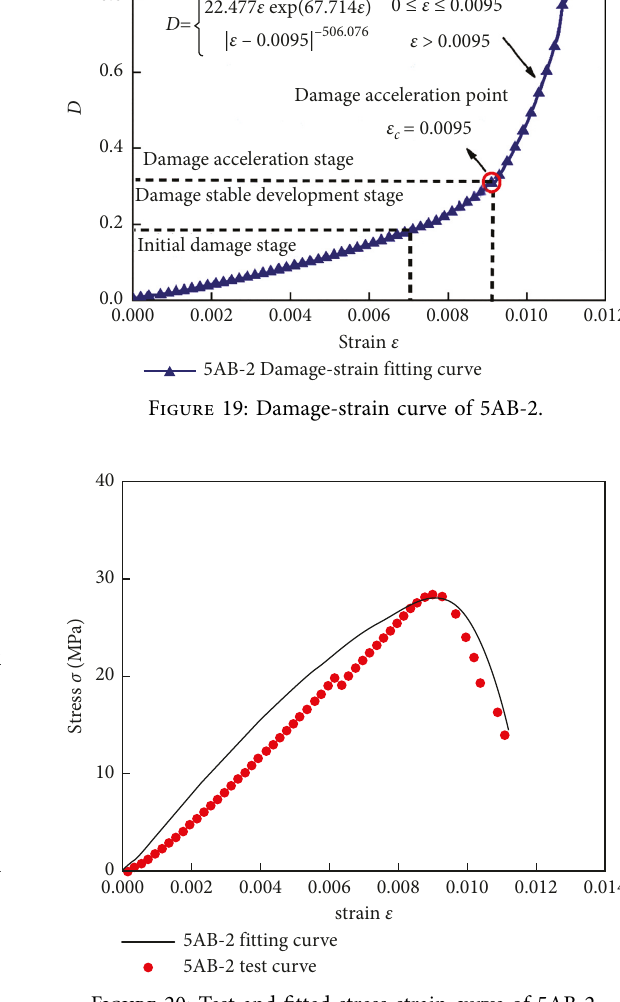
Figure 20: Test and fitted stress-strain curve of